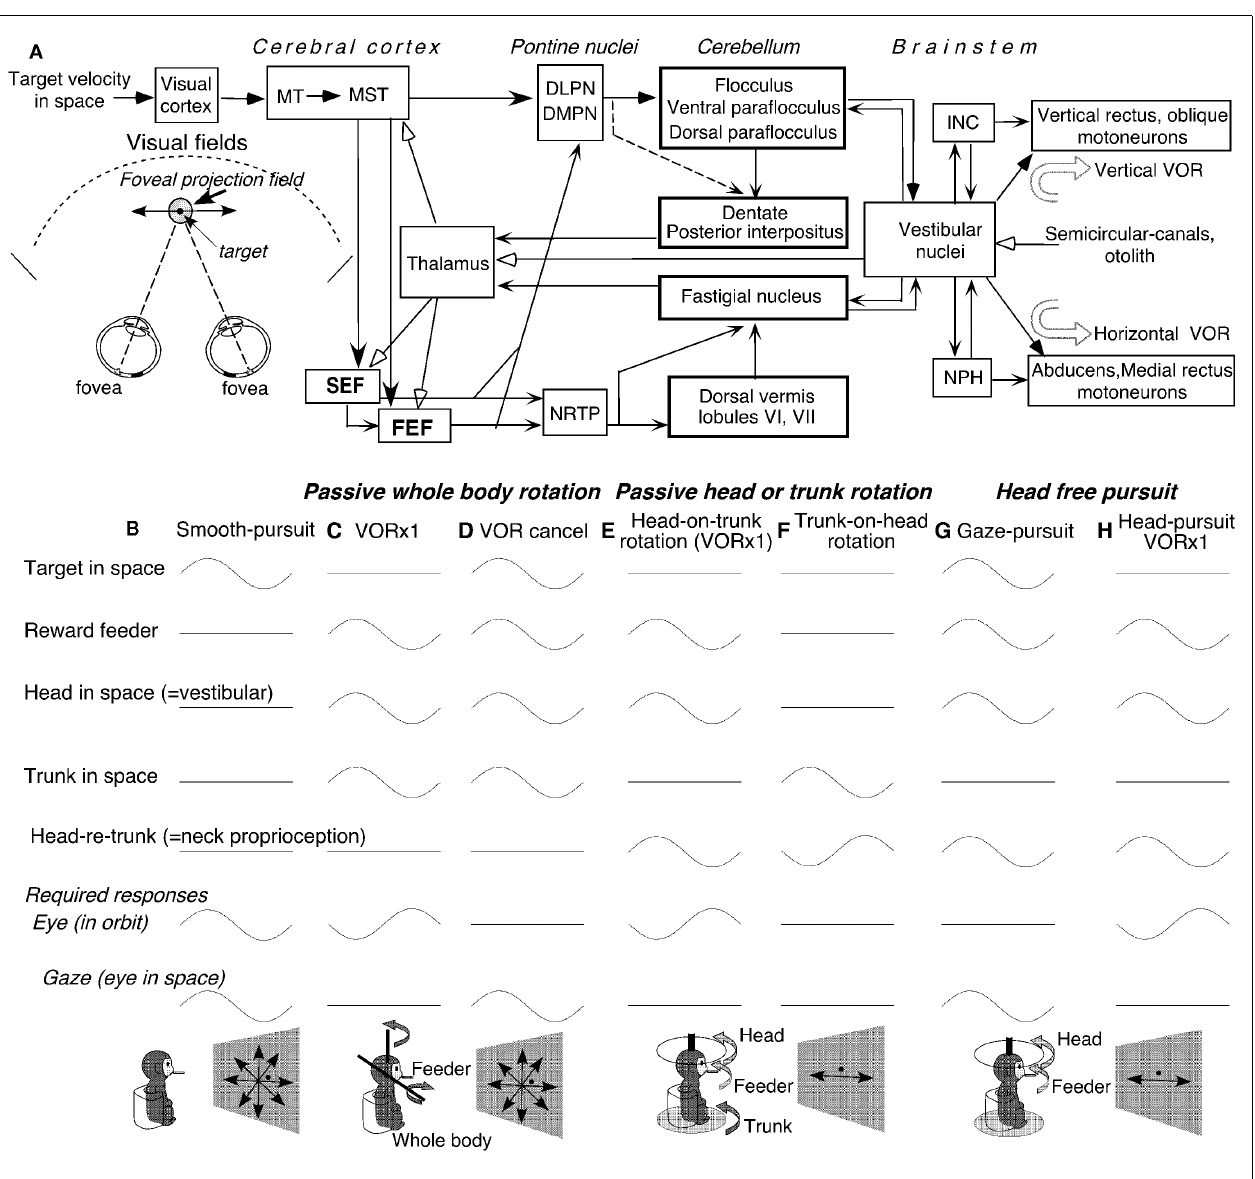
nucleus; INC, interstitial nucleus of Cajal; MT, middle temporal visual area; MST, medial superior temporal visual area; NRTP, nucleus reticularis tegmenti pontis; NPH, nucleus prepositus hypoglossi. For further explanation, see text. (A) Modified from Fukushima (2003a,b) and Fukushima et al. (2006) with permission. (B–H) Modified from Fukushima et al. (2009, 2010) with